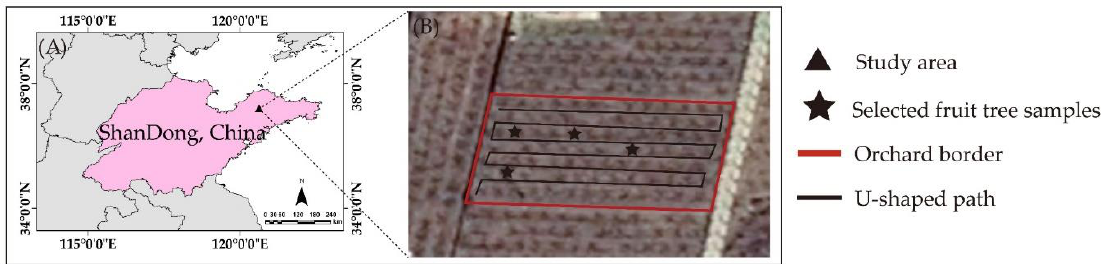
Figure 1. ( A ) Location of the orchard used in the study; ( B ) orchard boundary and backpack-LiDAR U-line data collection path and selected fruit tree samples.